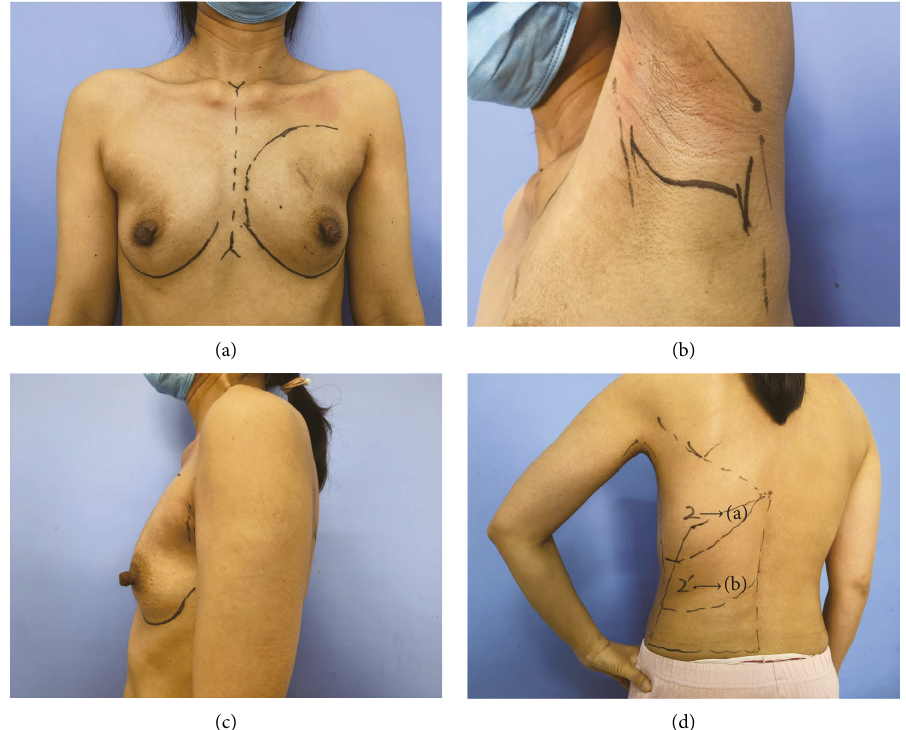
Figure 1: Preoperative marking. (a) Breast marking; (b) marking of the axillary incision line of approximately 4-5cm; (c) complete coverage of the incision by the sagged arm; (d) marking of the borders of the LD. (i) “Huaxi hole 2” is a manmade 0.5 cm incision located 2-3 cm inner to the posterior axillary line at a distance of 15–20 cm from the top of the axilla in the posterior and (ii) “Huaxi hole 2 ′ ” is determined by the required volume of LD muscle. Fan chart with around 15 cm radius with the axillary incision as the center represents the excision range from the axillary incision and the fan chart with around 15 cm radius with the “Huaxi hole 2” as the center represents the excision range from the “Huaxi hole